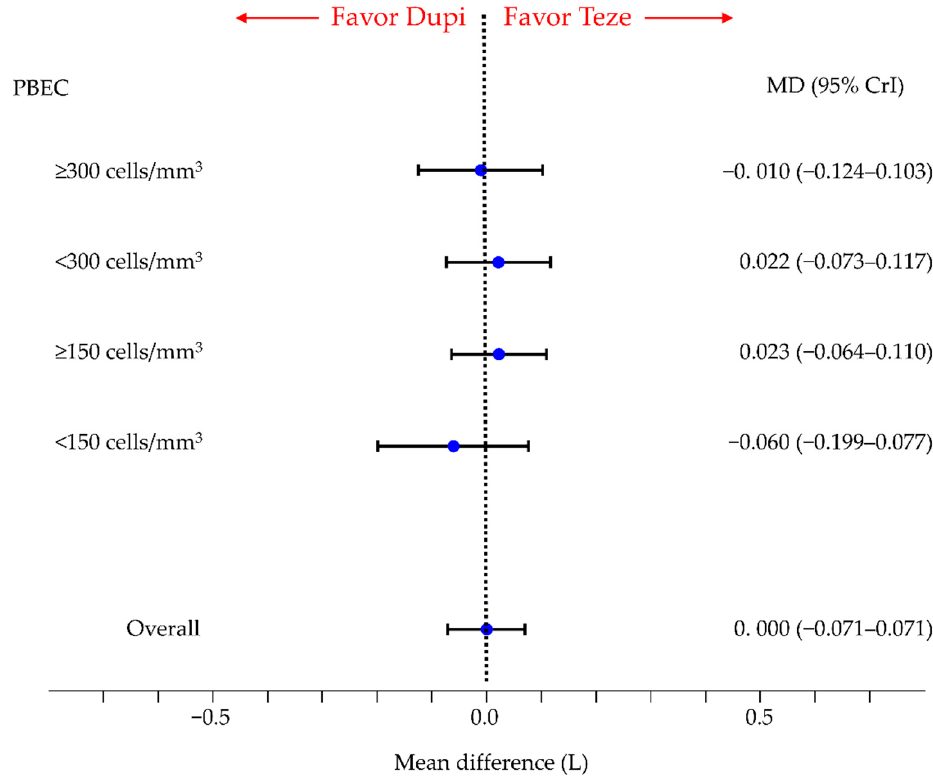
Figure 5. Comparative efficacy of tezepelumab and dupilumab in terms of the change in pre-BD FEV 1.0 in patients with inadequately controlled asthma in overall participants and subgroups based on PBEC thresholds. Comparisons are expressed as tezepelumab versus dupilumab. Data are expressed as mean differences (MDs) and 95% credible intervals (CrIs). pre-BD FEV 1.0 , pre-bronchodilator forced expiratory volume in one second; Teze, tezepelumab; Dupi, dupilumab; PBEC, peripheral blood eosinophil counts.